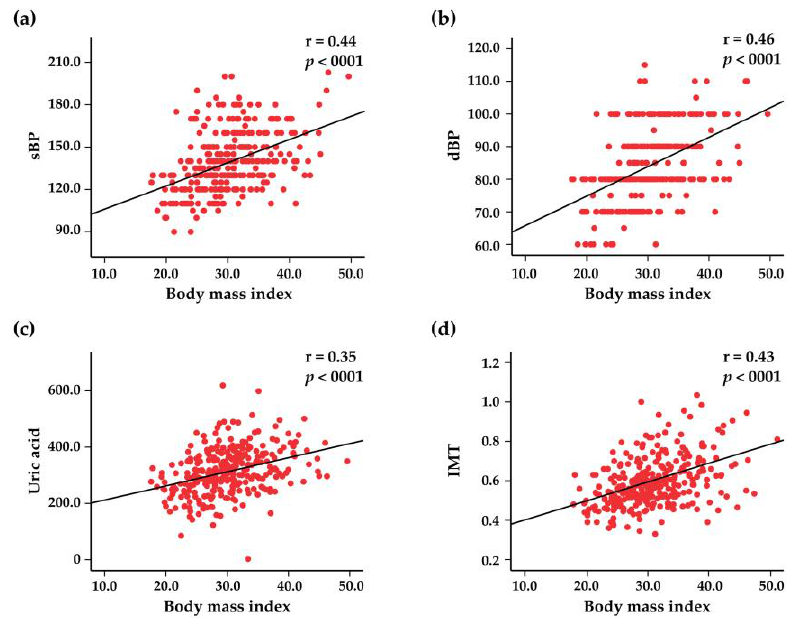
Figure 3. Scatter plots representing the correlations between the body mass index and systolic blood pressure (sBP) ( a ), diastolic blood pressure (dBP) ( b ), blood uric acid levels ( c ), and intima – media thickness (IMT) ( d ).